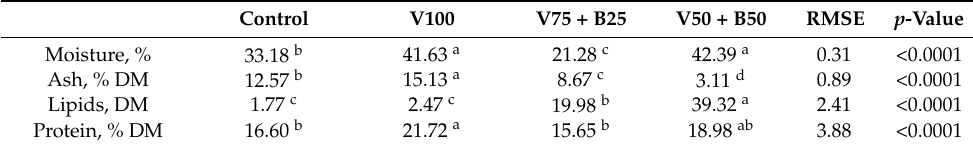
Table 8. Frass chemical